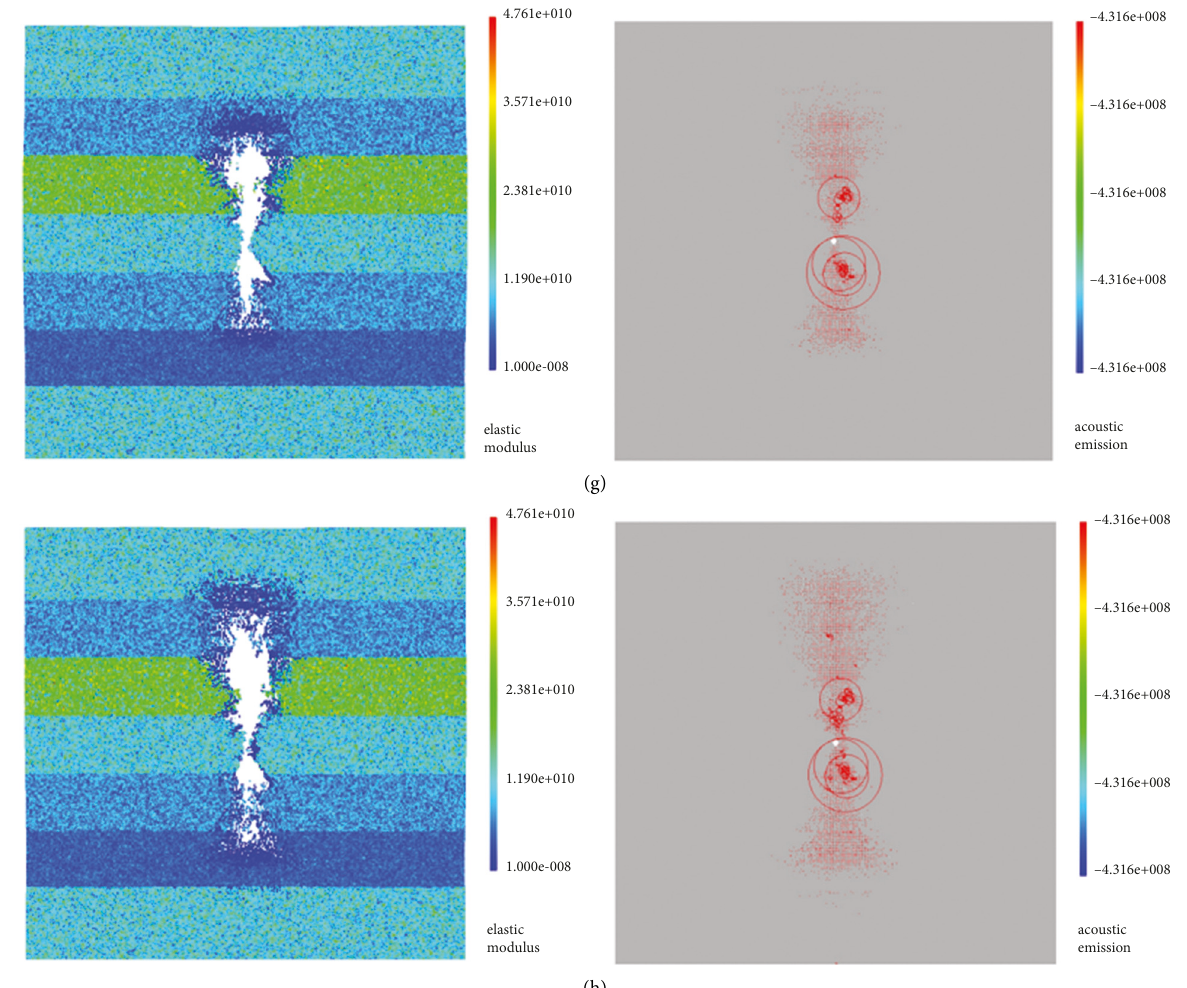
Figure 7: Elastic modulus and acoustic emission of numerical model No. 1. (a) Step 37–1. (b) Step 37–6. (c) Step 37–7. (d) Step